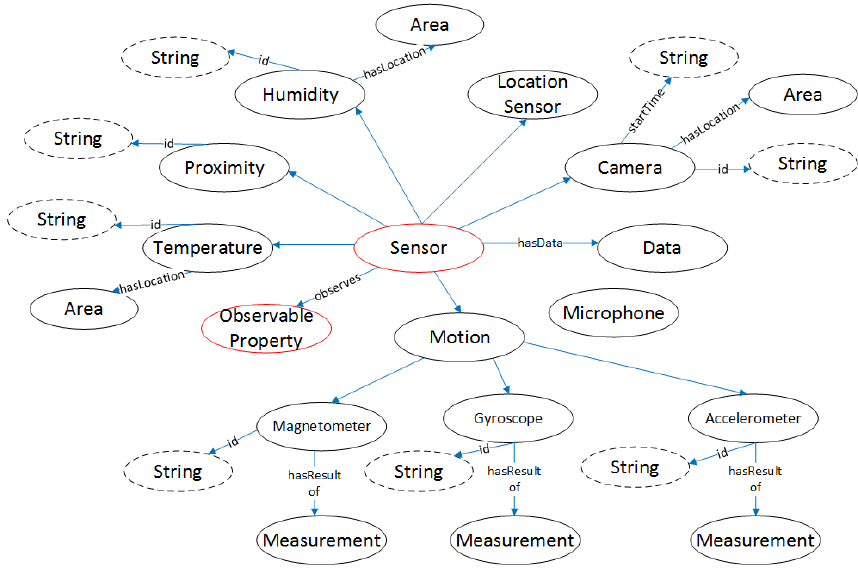
Figure 12. Sensor entity.